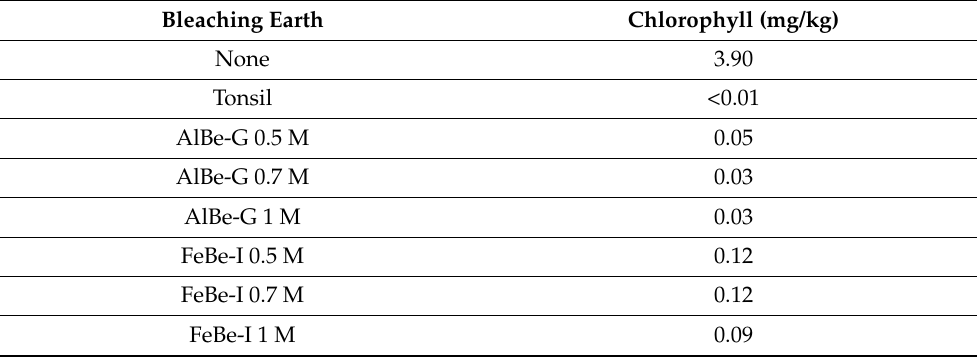
Table 4. Chlorophyll content of untreated and bleached oil samples (80 °C, t = 30 min, 250 rpm, 3% w / w ).